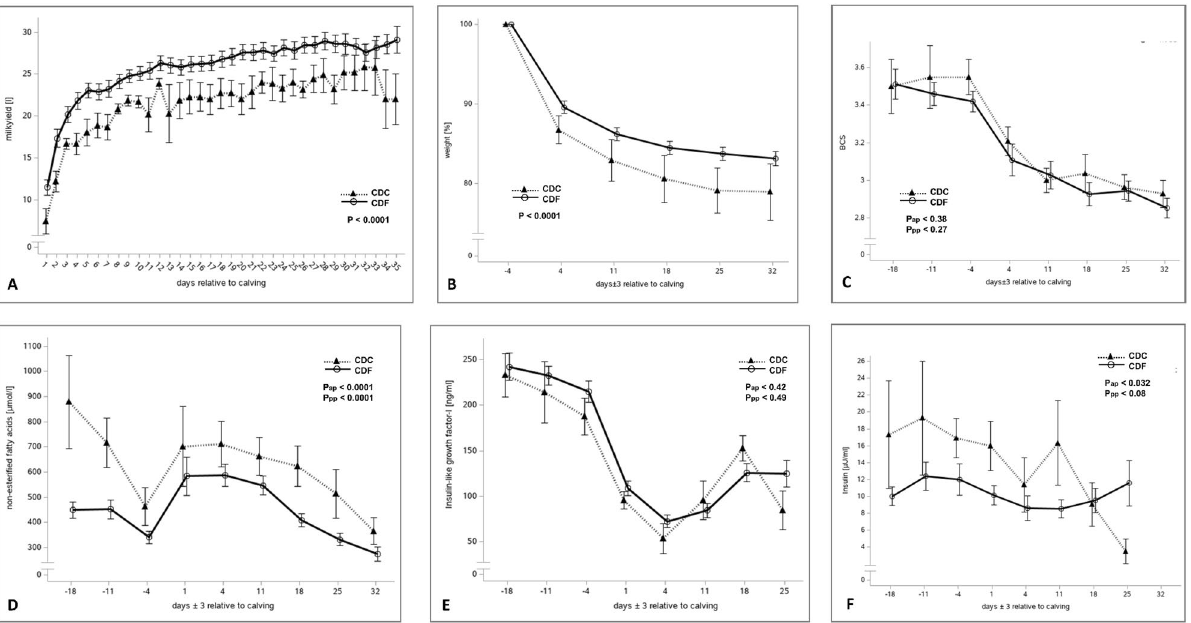
Figure 6. Clinical, biochemical and endocrinological characteristics of CDC cows compared to wild type CDF cows. ( A ) Energy-corrected milk, ( B ) body weight relative to weight, ( C ) body condition score, ( D) blood serum concentration for non-esterified fatty acids, ( E ) blood plasma concentrations of IGF-1, ( F ) blood plasma concentrations of insulin. Data points indicate mean and standard error of the